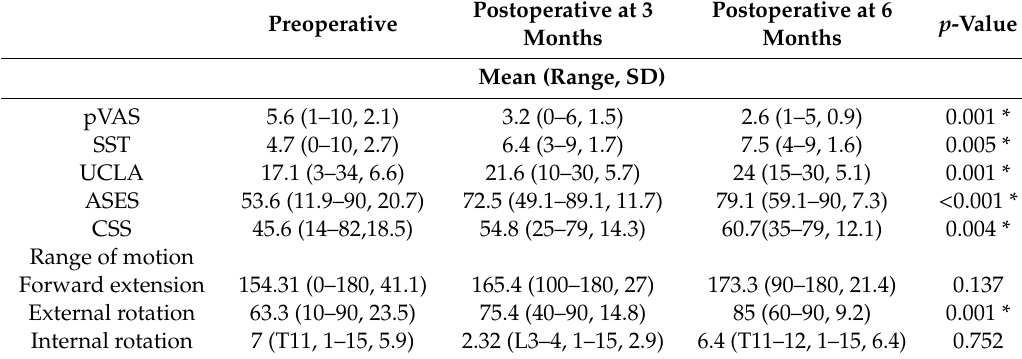
Table 2. Functional